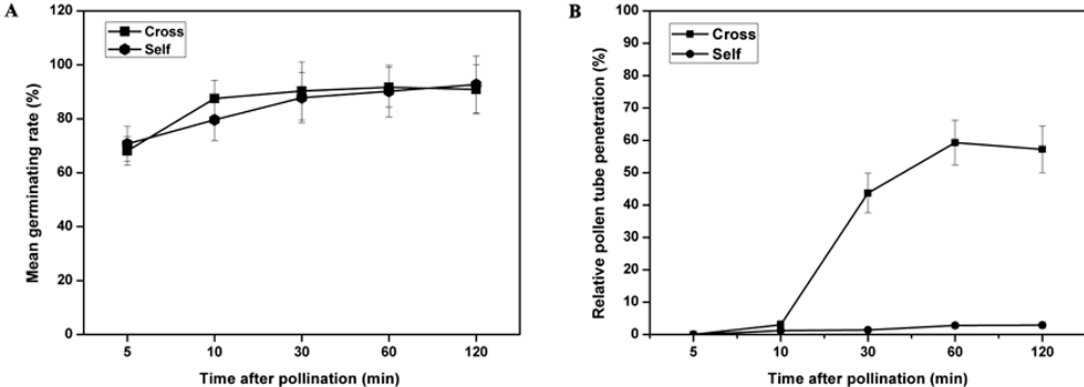
Figure 2. Statistical analysis of pollen germination and tube growth after self- and cross-pollination in sheepgrass. ( A ) Time course of pollen germination after pollination. No visible differences were observed in pollen grain germination for these two types of pollination. ( B ) Time course of pollen tube growth. Elongation of self-pollinated pollen tubes were inhibited from 10 to 30 min, and subsequently, the pollen tube growth was gradually stopped, while a majority of tubes reached the style base at 1–2 h after cross-pollination. Values represent the means ± SD.